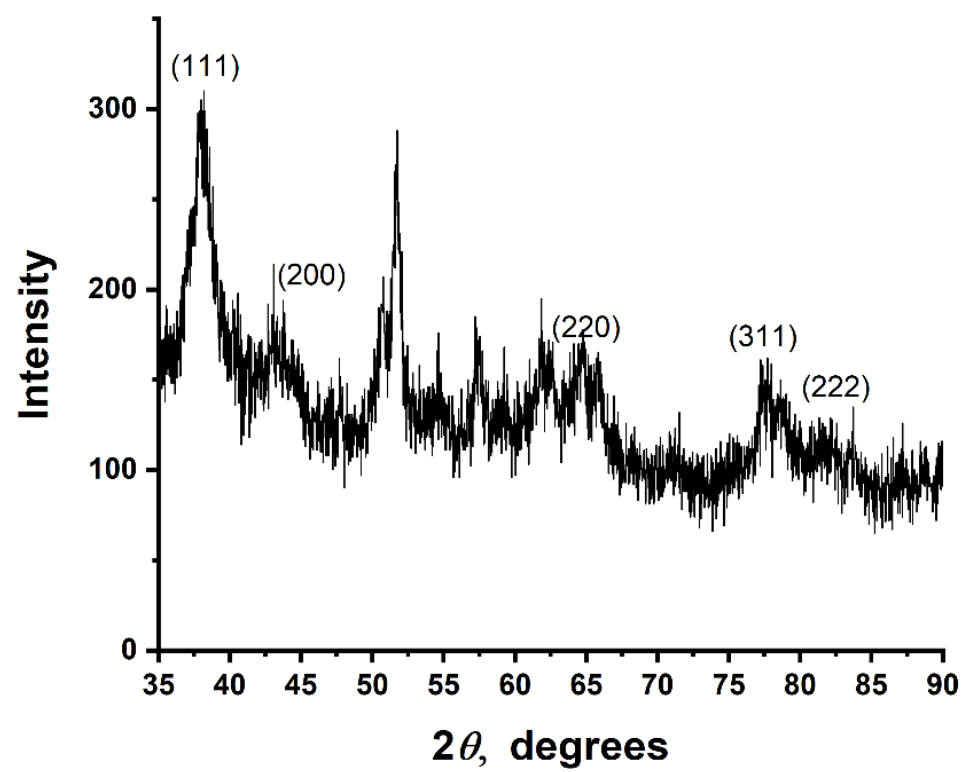
Figure 5. XRD spectrum of the synthesized Au NPs.